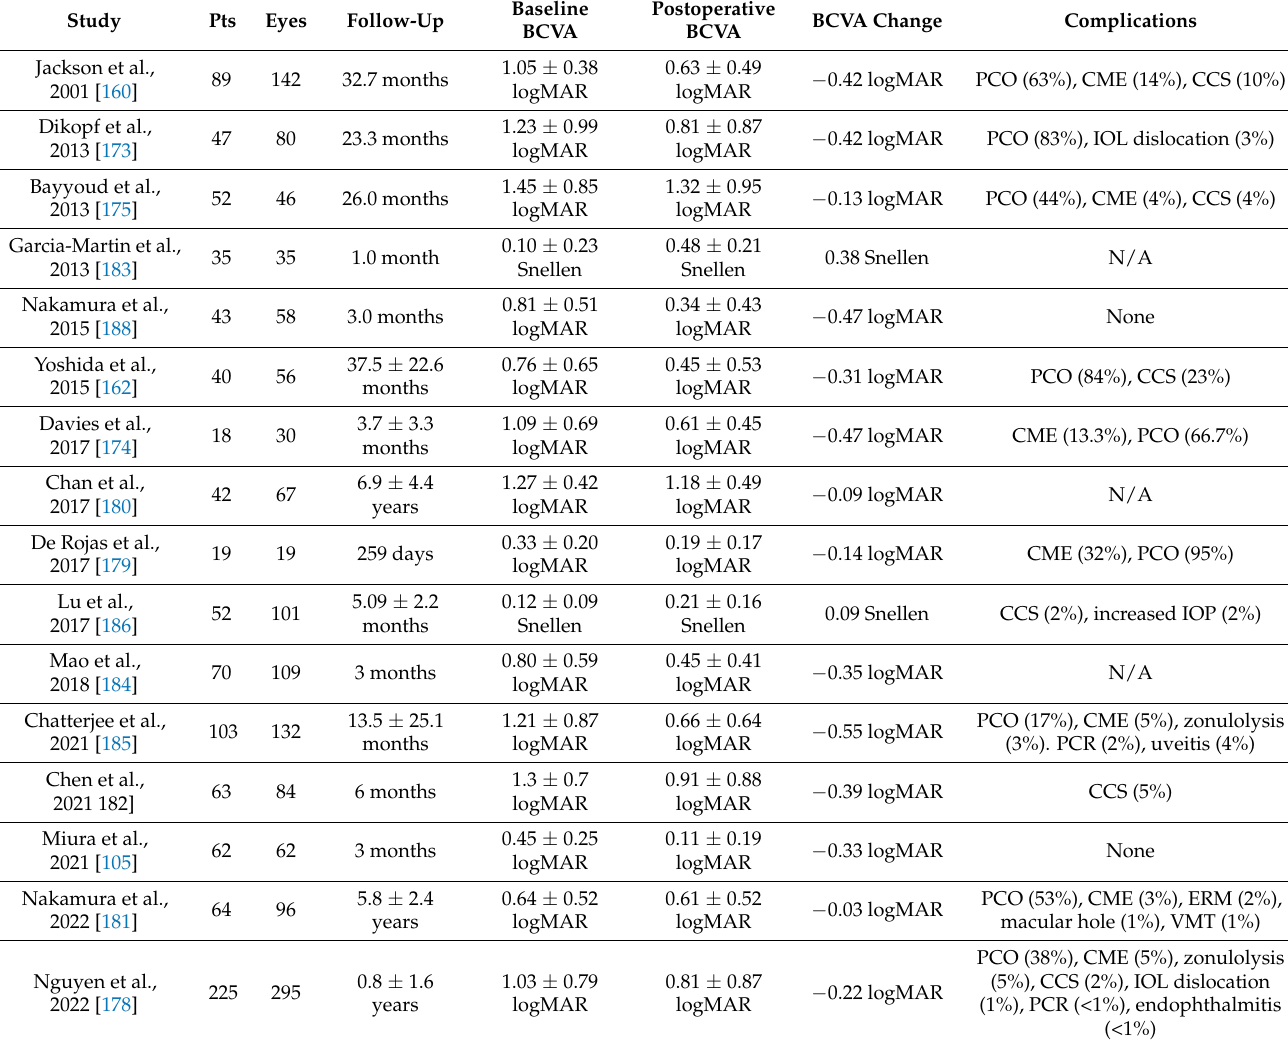
Table 1. Overview of studies on cataract surgeries in patients with retinitis